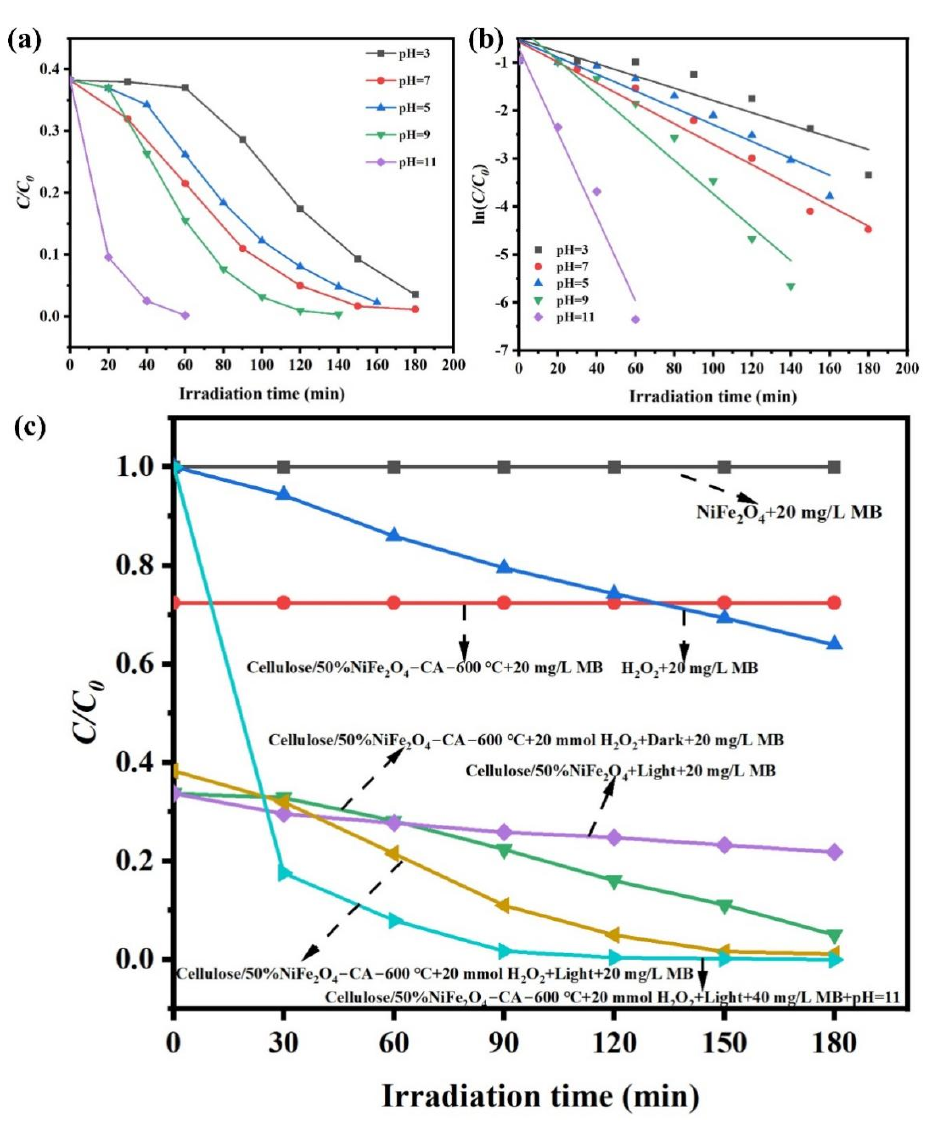
Figure 6. ( a ) Effects of different pH values. ( b ) Photodegradation kinetics curves with different pH values ( C 0 (MB) = 20 mg/L, n(H 2 O 2 ) = 20 mmol, m(cellulose/50%NiFe 2 O 4 − CA − 600 °C) = 50 mg). ( c ) Photodegradation effects under different conditions.